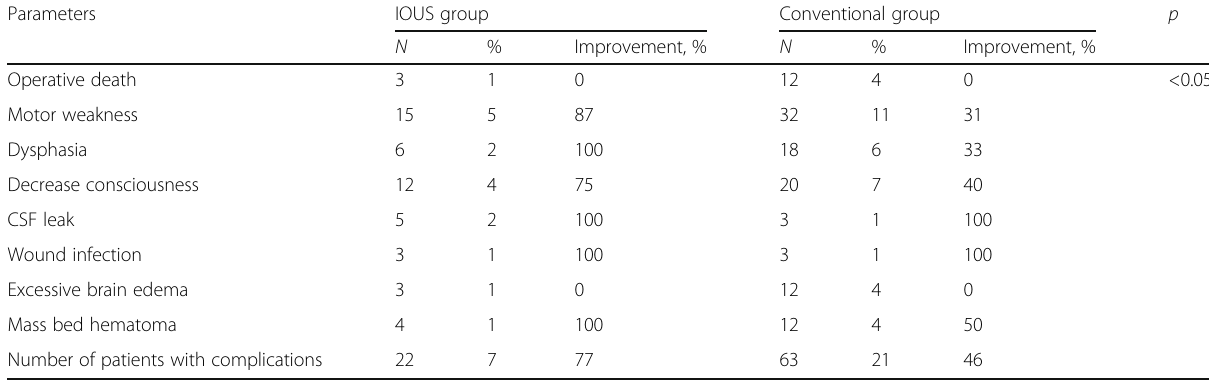
Table 3 Postoperative complications and fate at the third month Parameters IOUS